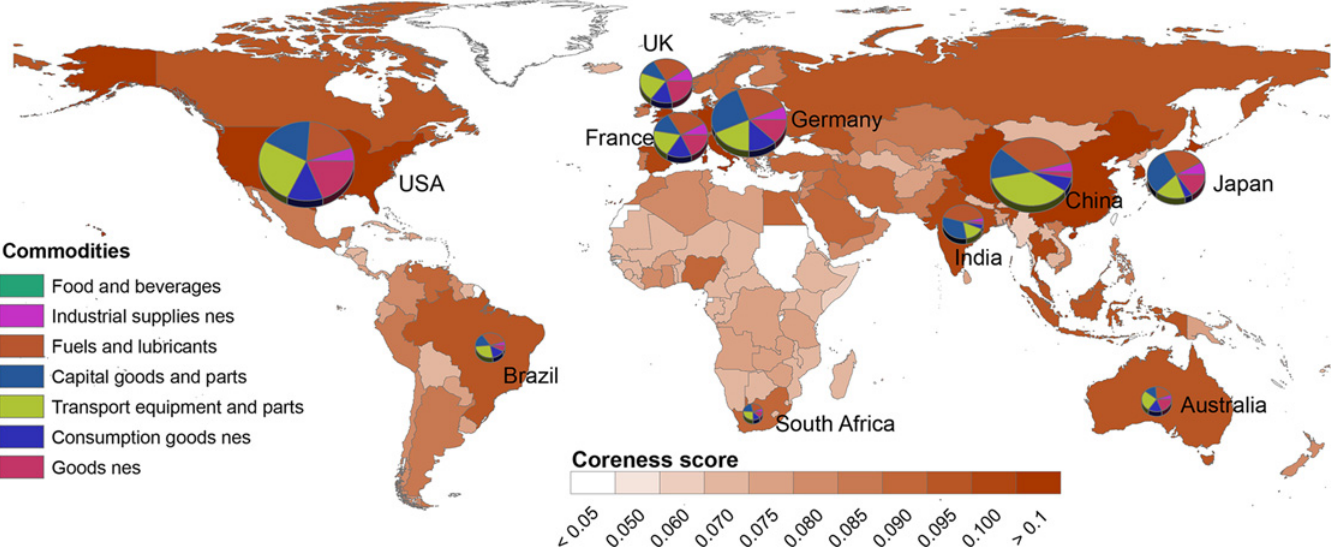
Fig 2. Global Map showing Countries ’ Integration and Patterns of Imports. Taken together, the map gives a heuristic sense for some of the global trade patterns, showing how well-integrated countries consist of both developed (e.g. USA, Germany and Japan) and developing (e.g. China and India) economies, and how these well-integrated countries differ according to their import